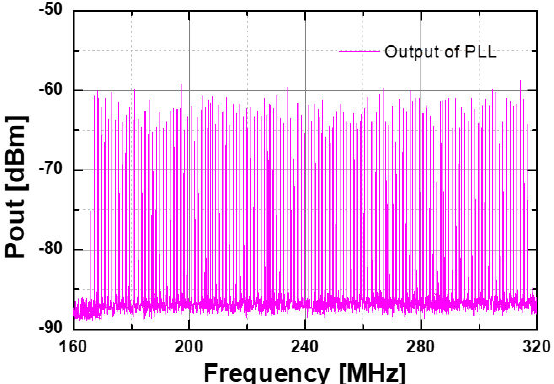
Figure 21. Measured down-converted output spectra of the frequency-modulated PLL with the